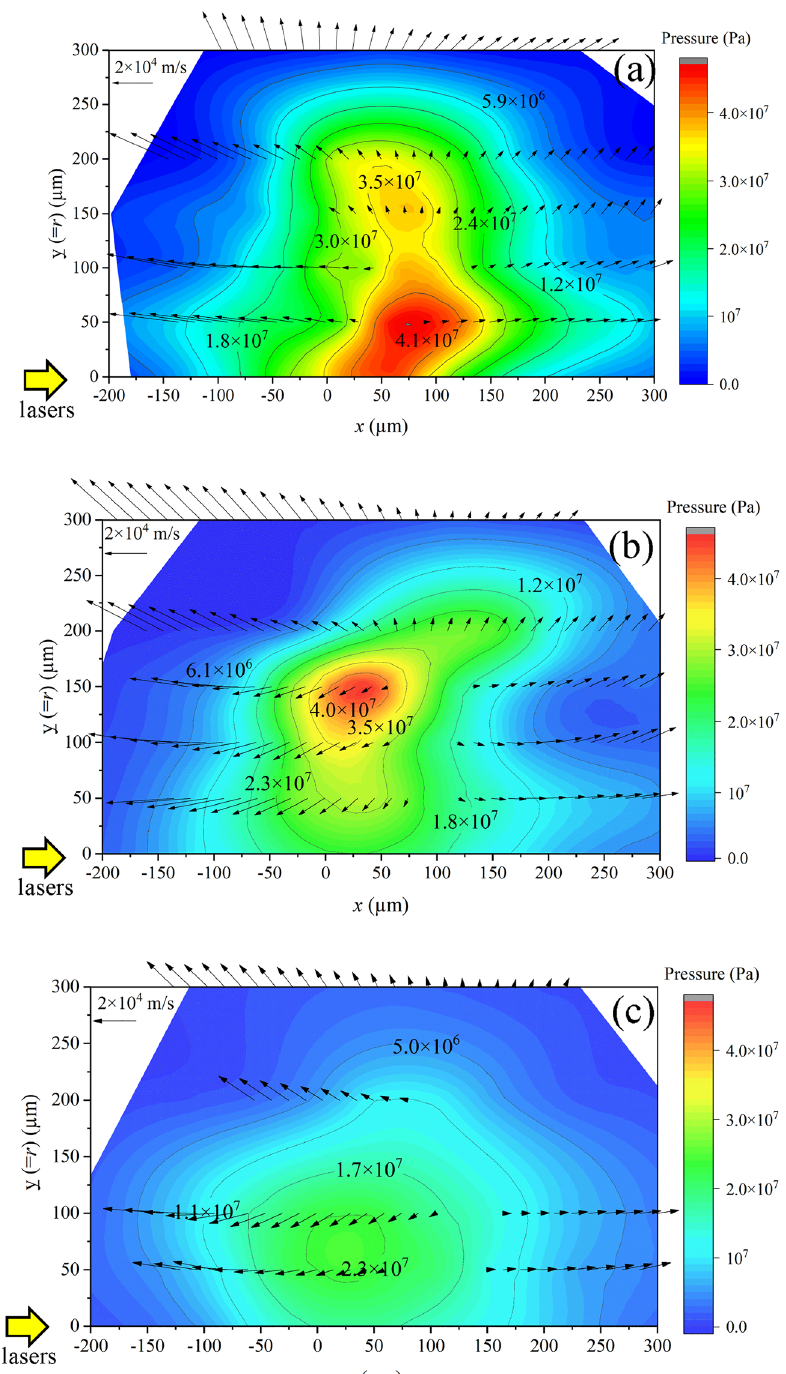
Figure 3. 2D-profiles of pressure and plasma flow-velocity field ( v flow ) of ( a ) the 1.3 µs-plasma, ( b ) the 2.0 µs-plasma, and ( c ) the 2.5 µs-plasma at a time of t = 10